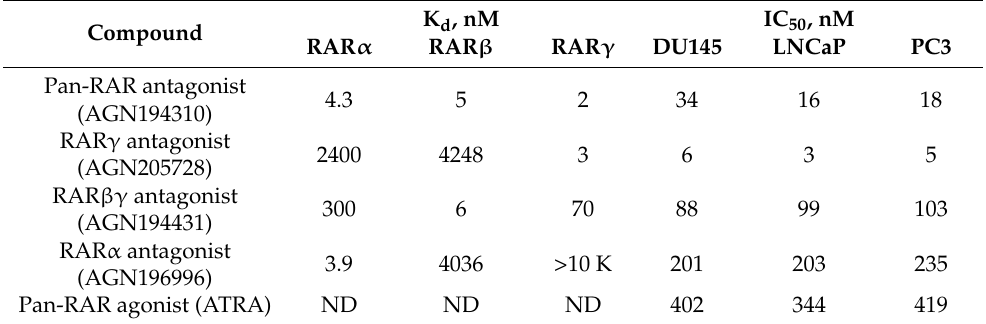
Table 2. Antagonism of RAR γ potently inhibits colony formation by prostate carcinoma cell